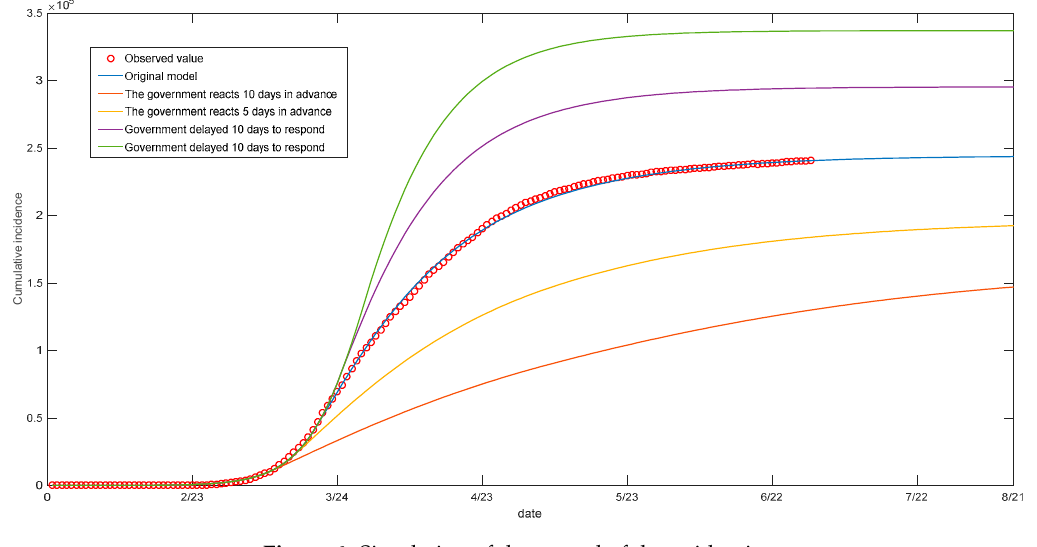
Figure 6. Simulation of the spread of the epidemic.